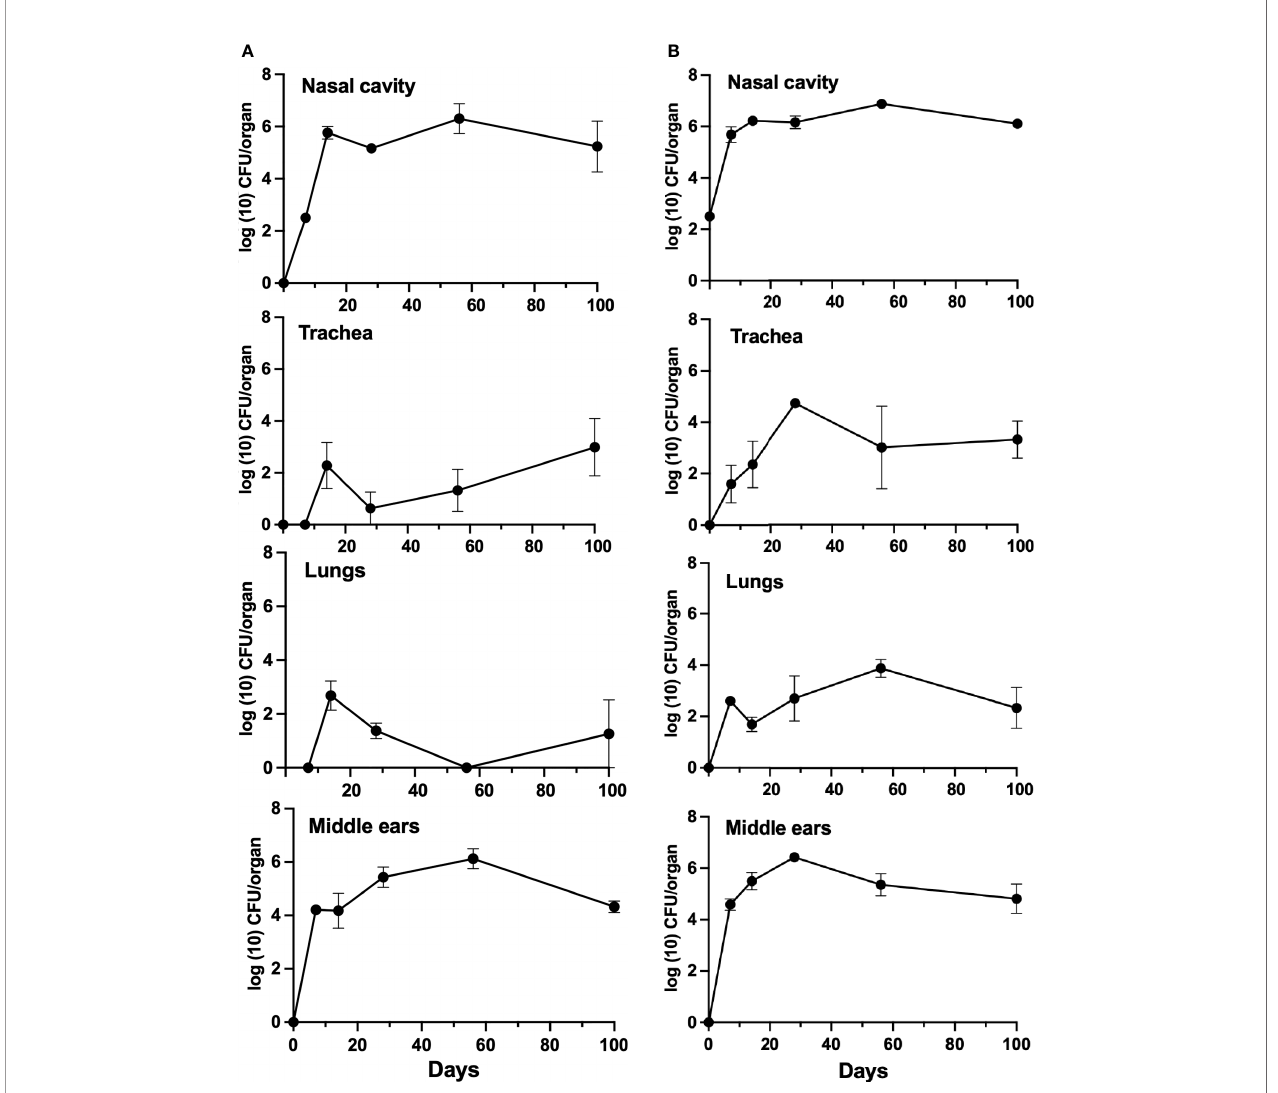
FIGURE 3 | Growth of B . bronchiseptica in B- and T-cell-de fi cient mice. Graphs represent the number of CFU recovered from the nasal cavity, trachea, lungs, and middle ears of groups of B-cell-de fi cient (left, panel A ) and T-cell-de fi cient (right, panel B ) mice. Error bars represent the standard deviation ( n =